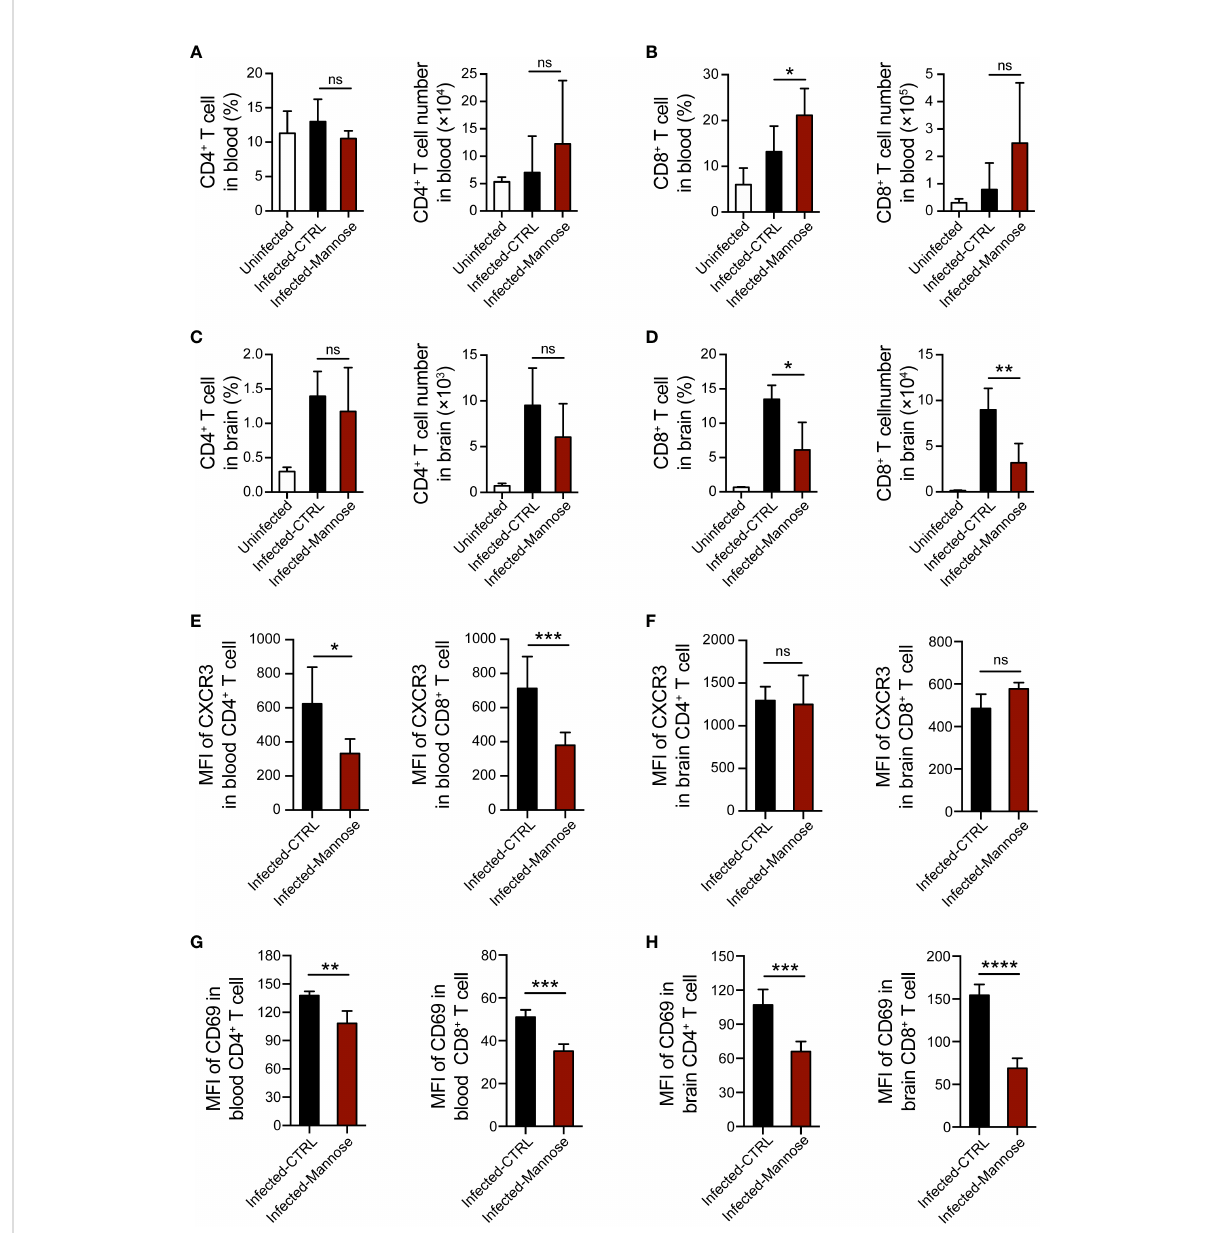
FIGURE 4 Mannose treatment suppresses T-cell activation and migration into the brain in infected C57BL/6 mice. (A, B) Mannose treatment promoted the T-cell response in peripheral blood from infected C57BL/6 mice. The frequency and number of CD4 + T cells (A) and CD8 + T cells (B) in peripheral blood mononuclear cells from uninfected (n = 4/group) and infected mice 7 days p.i. (n = 5-9/group) were quanti fi ed. (C, D) Mannose treatment in fl uenced T-cell in fi ltration in the brains of infected C57BL/6 mice. The frequency and number of CD4 + T cells (C) and CD8 + T cells (D) in brain mononuclear cells from uninfected (n = 3/group) and infected mice 7 days p.i. (n = 3-5/group) were quanti fi ed. (E, F) The mean fl uorescence intensity (MFI) of CXCR3 expression on CD4 + T cells and CD8 + T cells in the peripheral blood (E) and brains (F) of infected mice 7 days p.i. (G, H) The MFI of CD69 expression on CD4 + T cells and CD8 + T cells in the peripheral blood (G) and brains (H) of infected mice 7 days p.i. Data are presented as mean ± SD and were analyzed by unpaired t test or Mann-Whitney U test. * P < 0.05, ** P < 0.01, *** P < 0.001, **** P < 0.0001, and ns, not signi fi